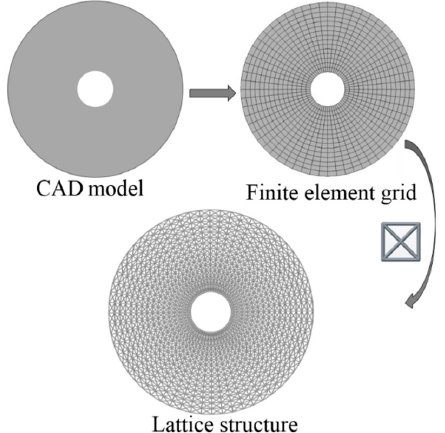
Figure 12. Illustrations of lattice structure generation for hollow round.